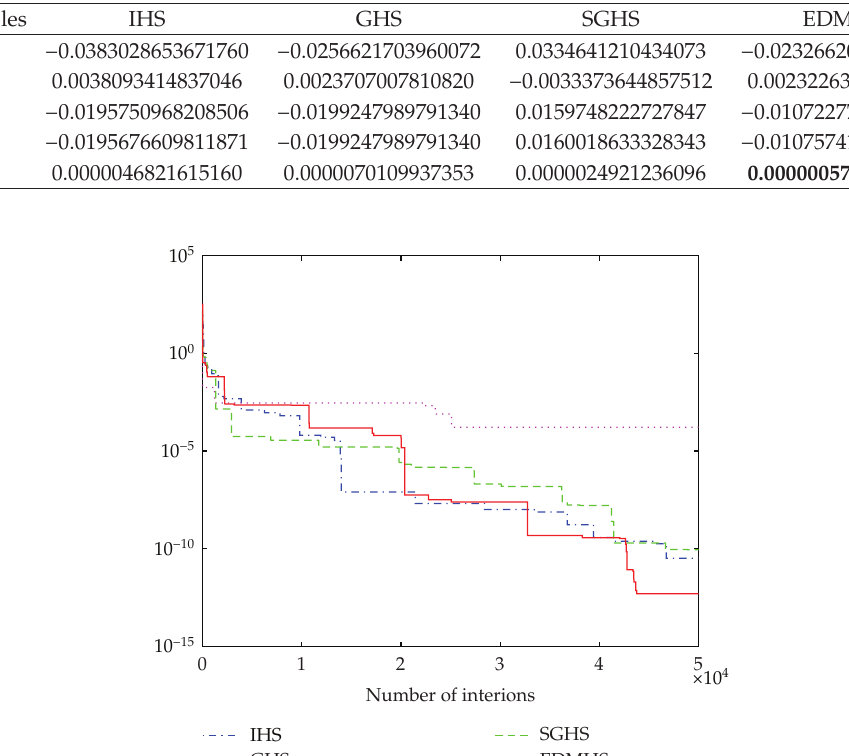
Table 5: Four HS algorithms for Powell quartic function.